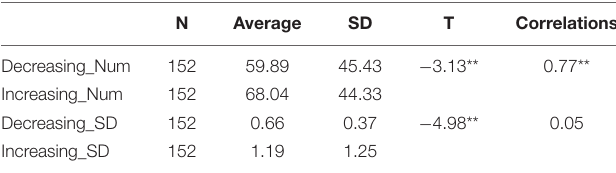
TABLE 2 | The dynamic evaluation of valence during music